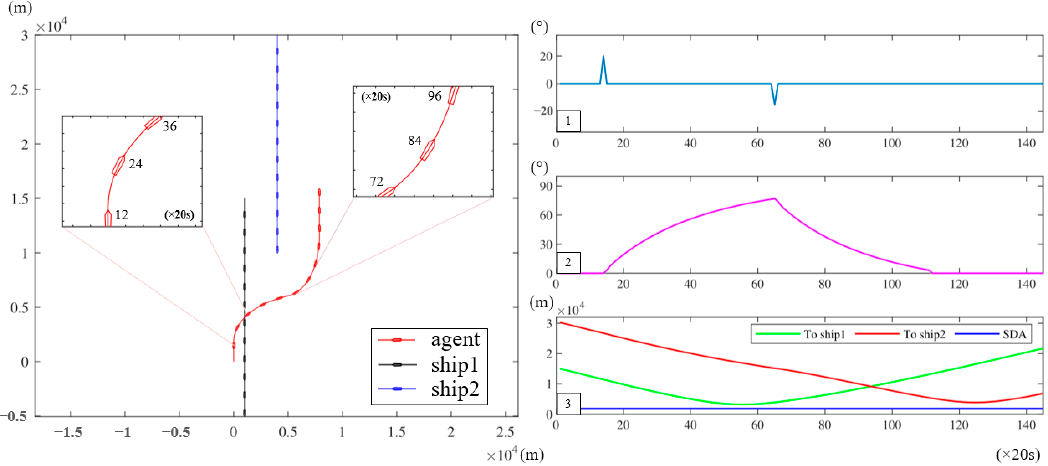
Figure 13. Simulation result for multi-ship-collision avoidance (1: rudder angle; 2: course; 3: distance).